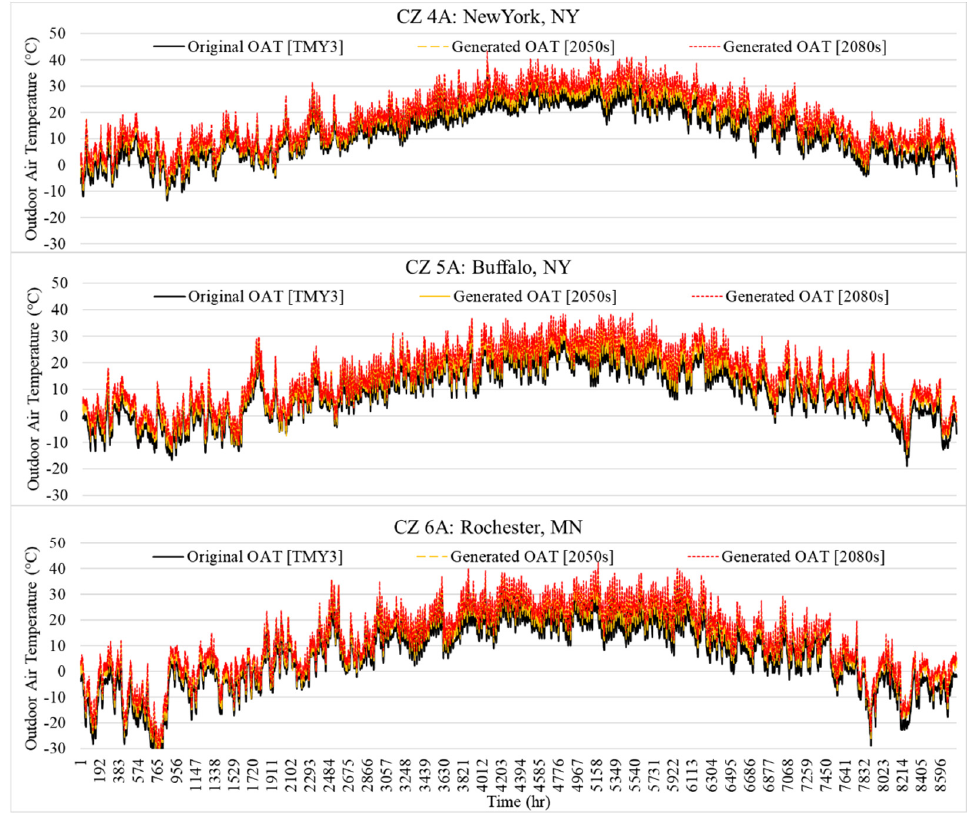
Figure 9. Profiles of generated outdoor air temperatures (OATs) for the scenarios in each climate location.